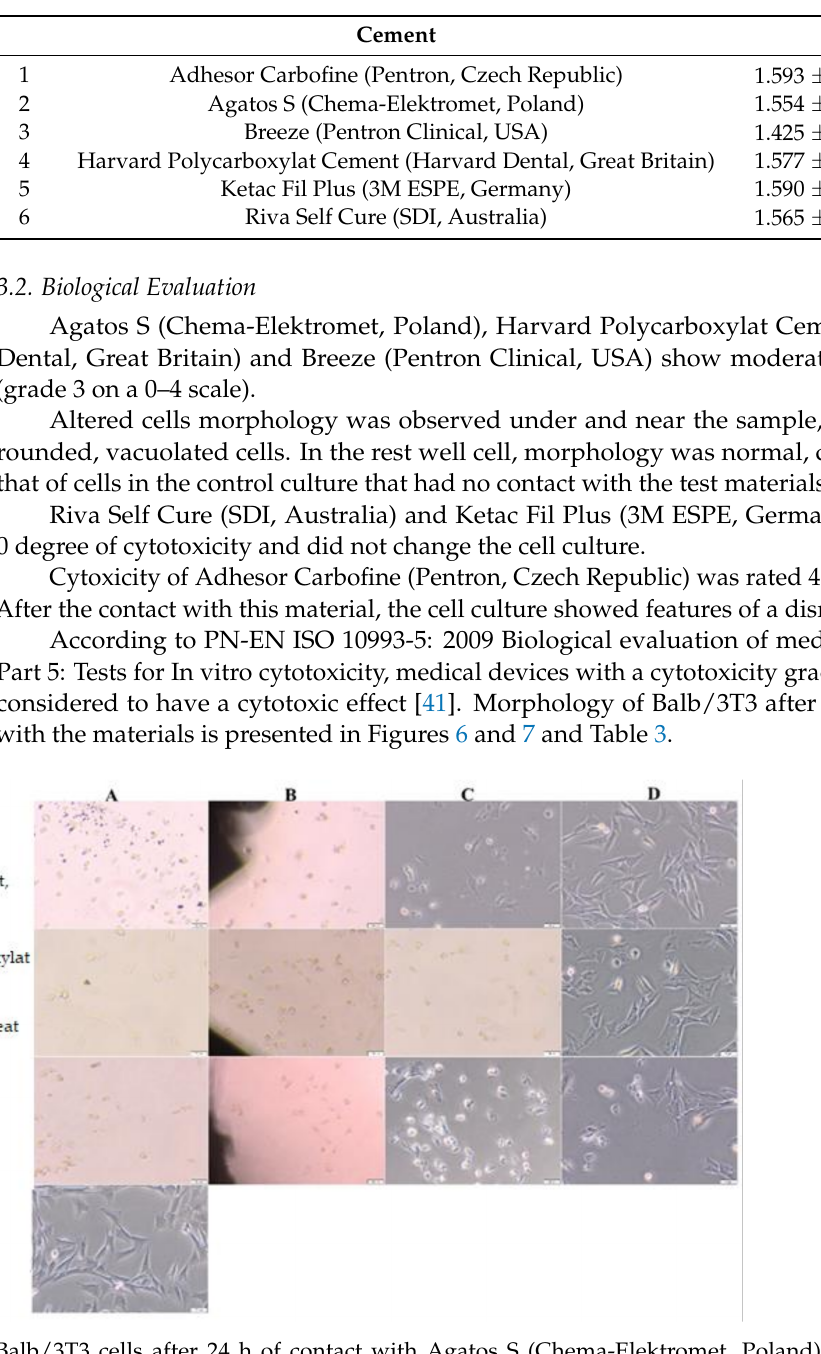
Figure 6. Morphology of Balb/3T3 cells after 24 h of contact with Agatos S (Chema-Elektromet, Poland), Harvard Polycarboxylat Cement (Harvard Dental, Great Britain) and Breeze (Pentron Clinical, USA); ( A ) under and ( B ) near the cement, ( C ) in area up to 1 cm, ( D ) in area more than 1 cm. Control culture had no contact with the test materials. Magn. 100 ×